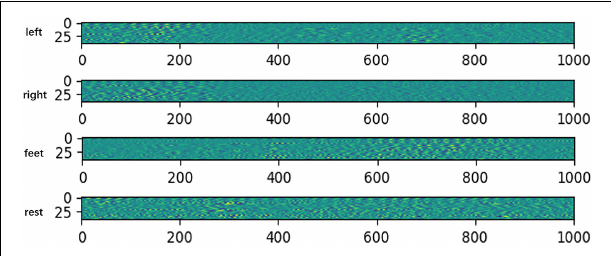
FIGURE 3 | Features map after extracting temporal feature on HGD. The x -axis denotes time, and the y -axis denotes the channel.